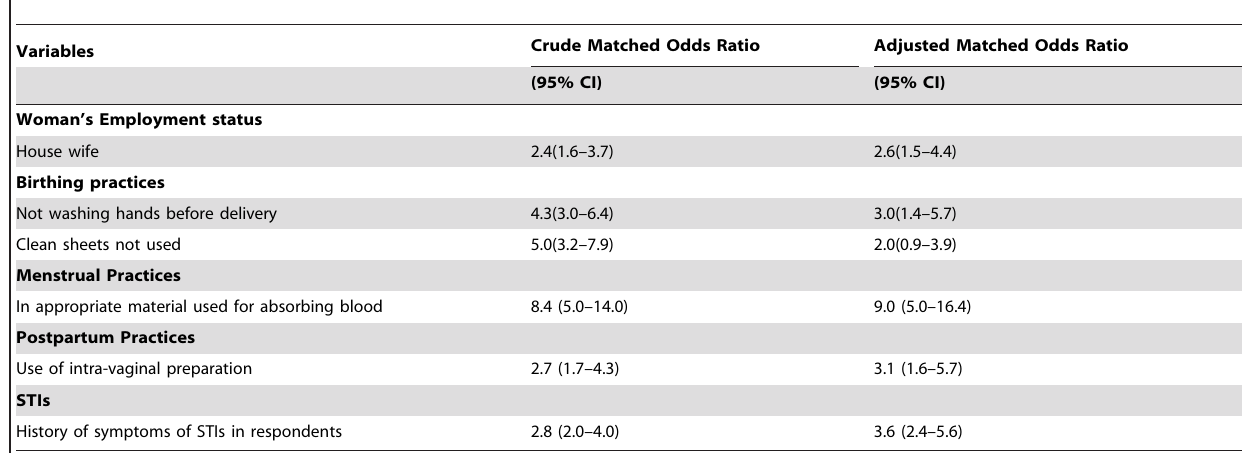
Table 3. Final multivariable conditional logistic regression model of risk factors associated with secondary infertility in Karachi,